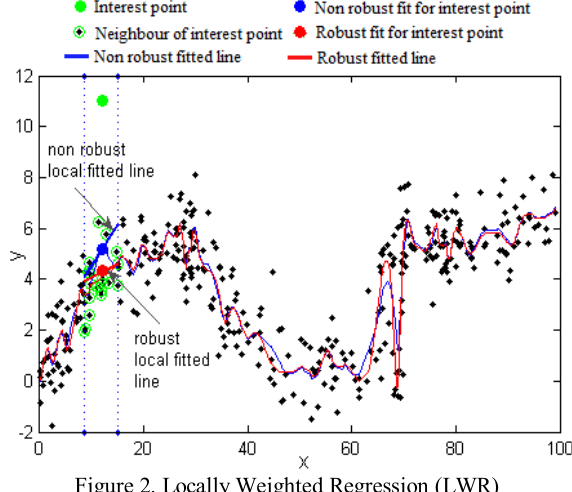
Figure 1. Tricube and bisquare weight functions